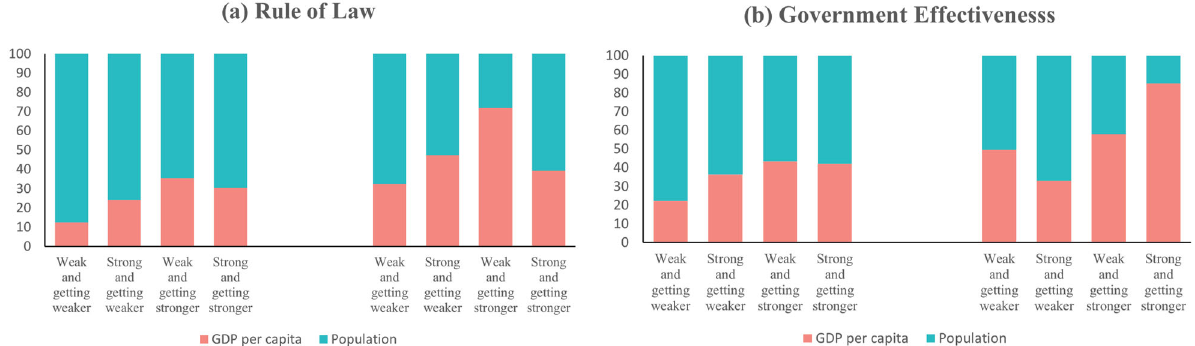
Fig. 4 Percentage of ULE explained by GDP per capita growth rate and population growth rate for governance indicators in pre-2000 and post-2000. a Rule of Law and b Government